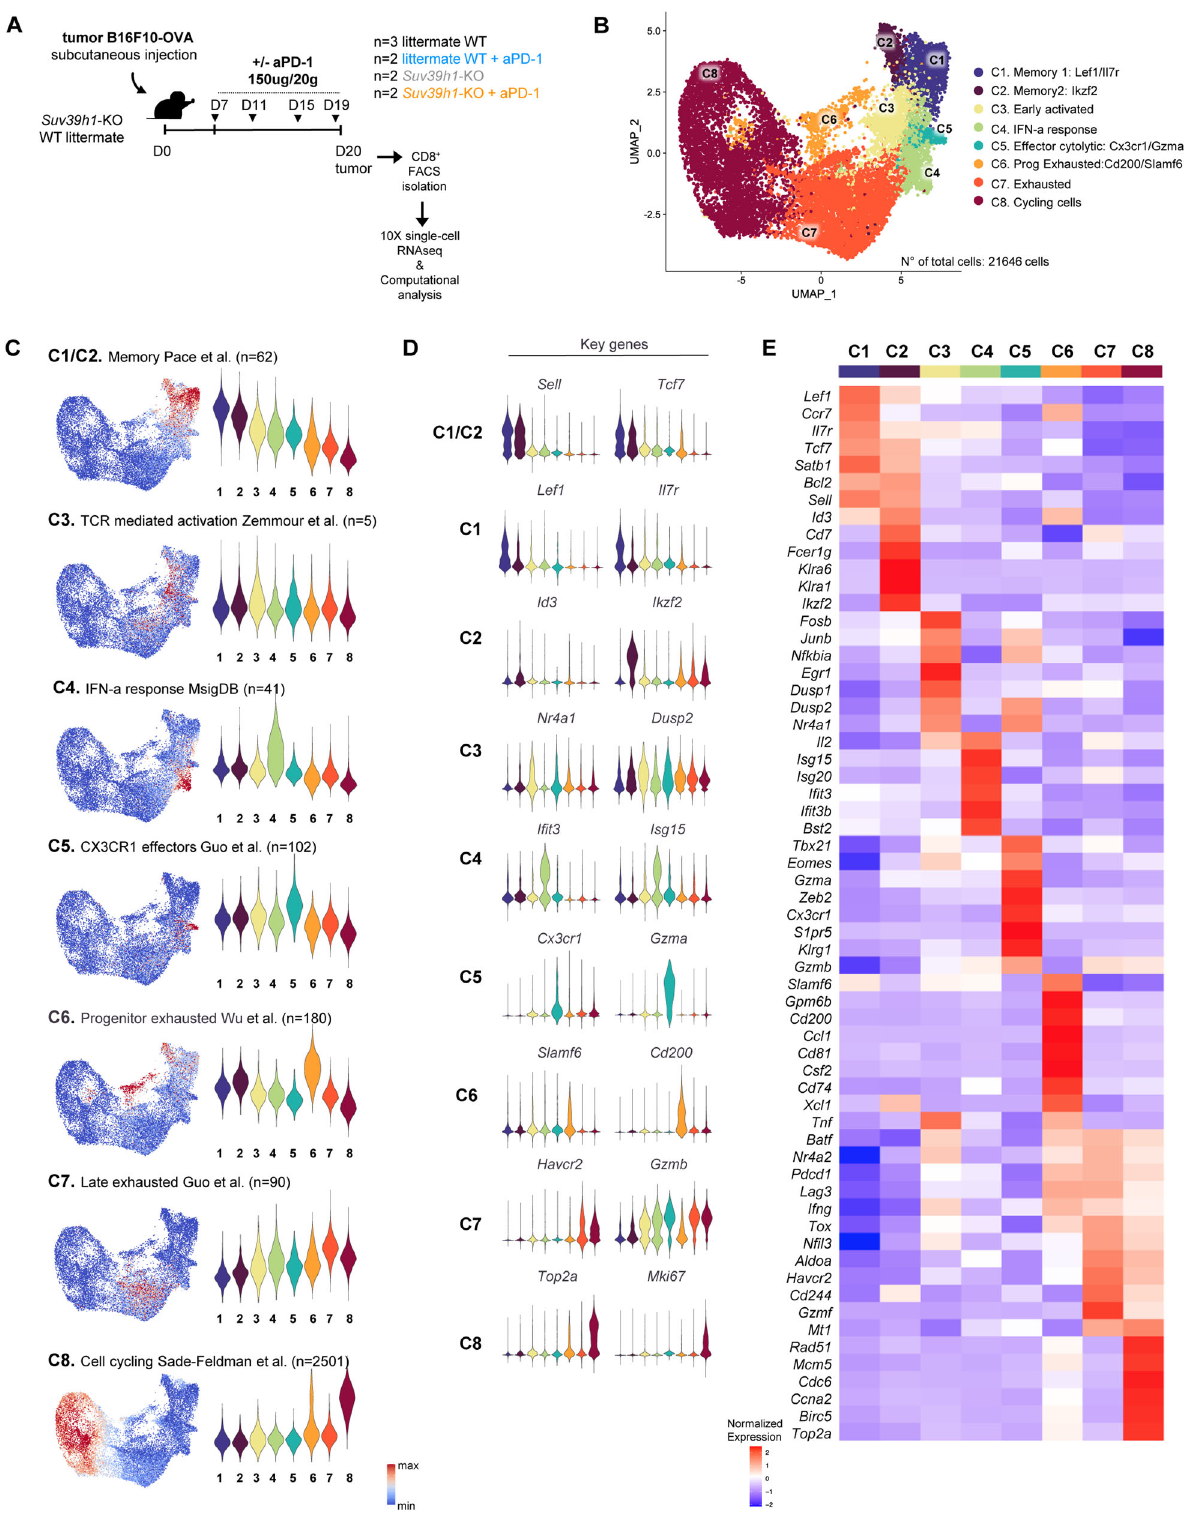
Fig. 3 Identi fi cation of multiple CD8 + TIL populations by single cell RNA sequencing. A Scheme of the overall study design. Single – cell RNA sequencing was applied to CD8 + TILs isolated from littermate WT and Suv39h1 -KO mice receiving B16F10-OVA melanoma cells followed by PBS or anti-PD-1 Ab. B UMAP plot with clusters differentiated by colour demonstrating eight distinct CD8 + TILs clusters based on gene expression differences for 21646 passing quality control cells. Each dot corresponds to one single cell. C Feature plots and violin plots showing distribution of signature scores indicated by cluster. D Violin plots showing expression distribution of representative genes for each cluster. E Heatmap showing Z scores for the average expression of selected genes within the eight clusters. See also Supplementary Fig. 4. Source data are provided as a Source Data fi le.